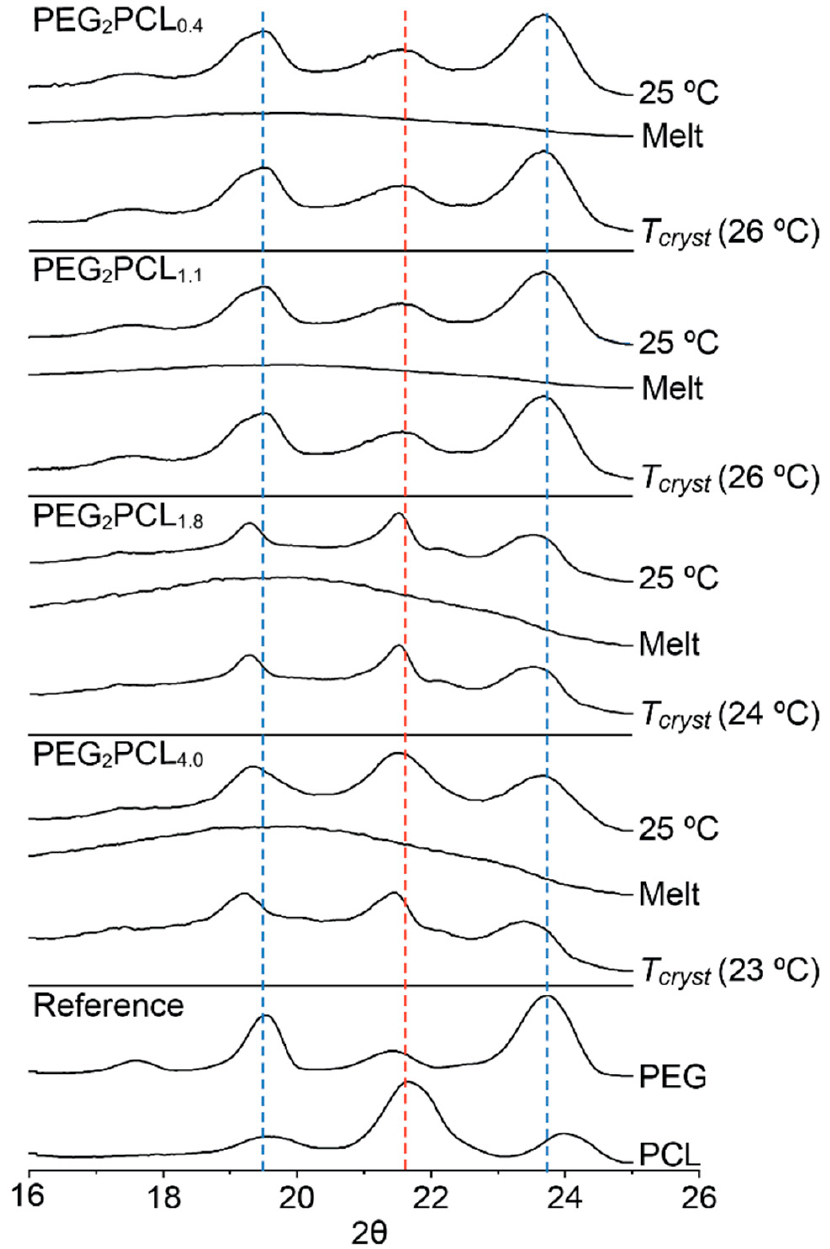
Figure 3. Stacked WXRD diffraction patterns of the PEG 2 and PCL 2 homopolymers recorded at 25 °C, and the PEG 2 PCL y block copolymers recorded before thermal treatment at 25 °C (as precipi ‐ tated), in the molten state at 80 °C, and at T cryst upon cooling. Despite the apparent amorphousness of the PCL block for the PEG 2 PCL 0.4 and